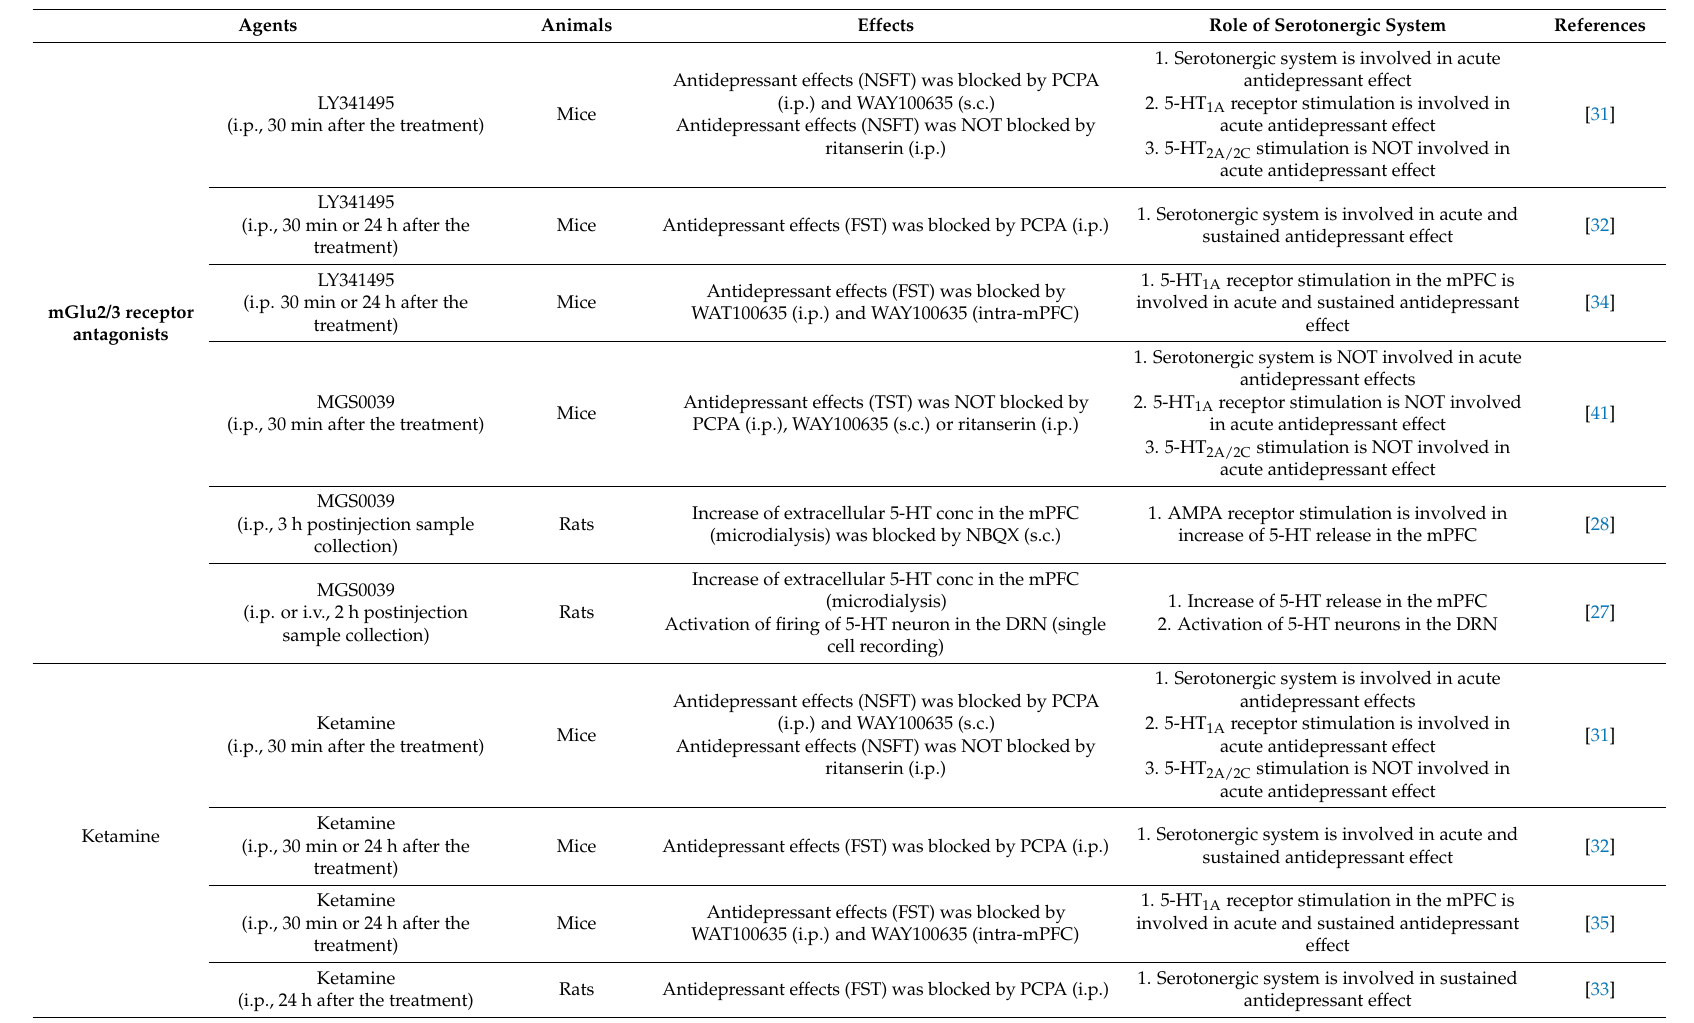
Table 1. Summary of role of serotonergic system in antidepressant effects of mGlu2/3 receptor antagonists and